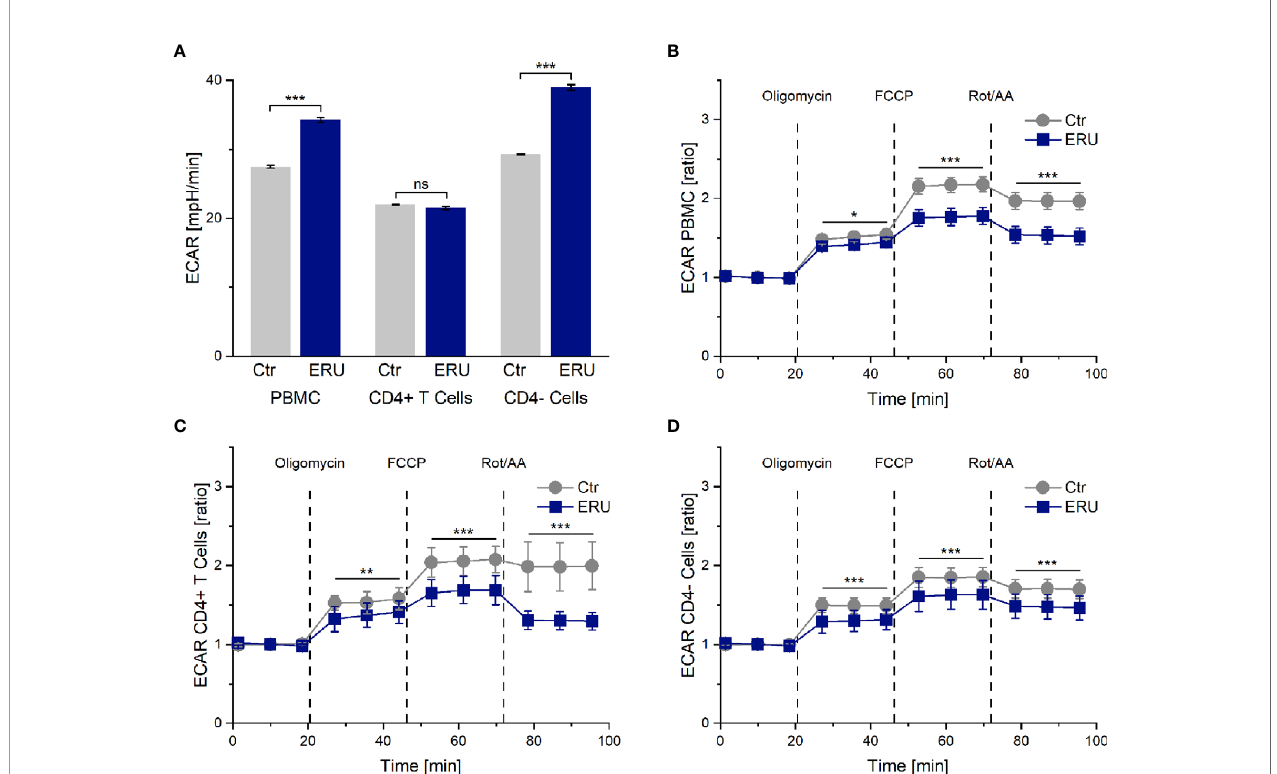
FIGURE 2 | Extracellular acidi fi cation rate (ECAR) of PBMC, CD4 + T cells and CD4 - cells of healthy and ERU cases. Graphs display the extracellular acidi fi cation rate (ECAR) of cells of healthy (grey, n=14) and ERU diseased cases (blue, n=8). Graph (A) shows extracellular acidi fi cation rates, graphs (B – D) show ECAR ratios of healthy and ERU cases. First three measurements (dots) show basal respiration, followed by injections of oligomycin (after the third measurement point), FCCP (after the sixth measurement point) and Rot/AA (after the ninth measurement point). Data are shown as mean ± SEM. (A) PBMC and more speci fi cally CD4 - cells of ERU cases showed signi fi cantly increased basal extracellular acidi fi cation (***p ≤ 0.001) compared to controls, whereas no signi fi cant difference (ns p > 0.05) between the basal extracellular acidi fi cation rate of CD4 + T cells of healthy and diseased horses was detectable. (B) ECAR ratio of PBMC of ERU cases decreased signi fi cantly after injection of the reagents of the mito stress test. (C) CD4 + T cells had a signi fi cantly lower ECAR ratio than controls after injection of oligomycin, FCCP and Rot/ AA. (D) ECAR ratio of CD4 - cells was signi fi cantly lower in ERU cases than in controls after injection of the mito stress test reagents. Statistical signi fi cances are represented by asterisks (*p ≤ 0.05; **p ≤ 0.01; ***p ≤